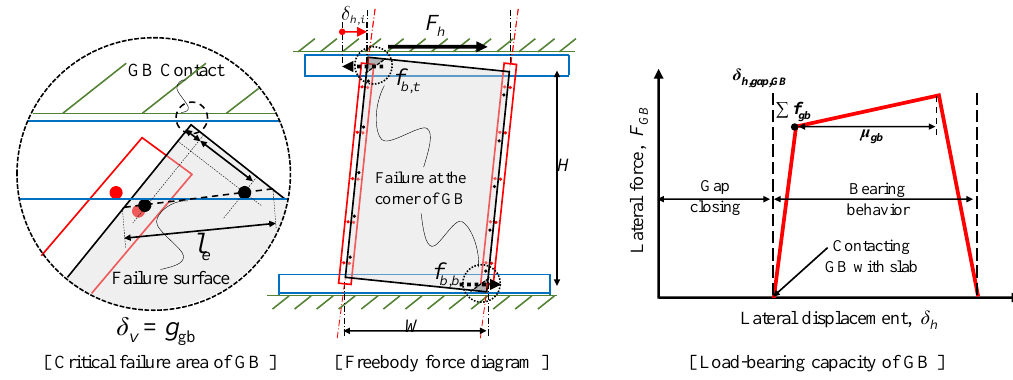
Figure 4. Free-body diagram and monotonic behavior of gypsum boards.